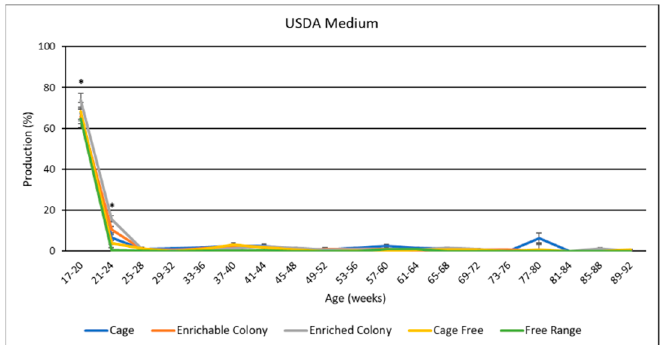
Figure 11. The effect of housing system on USDA medium production of brown egg layers by age. * Signifies a significant effect ( p < 0.05) of housing environment during that age range on USDA medium percentage.